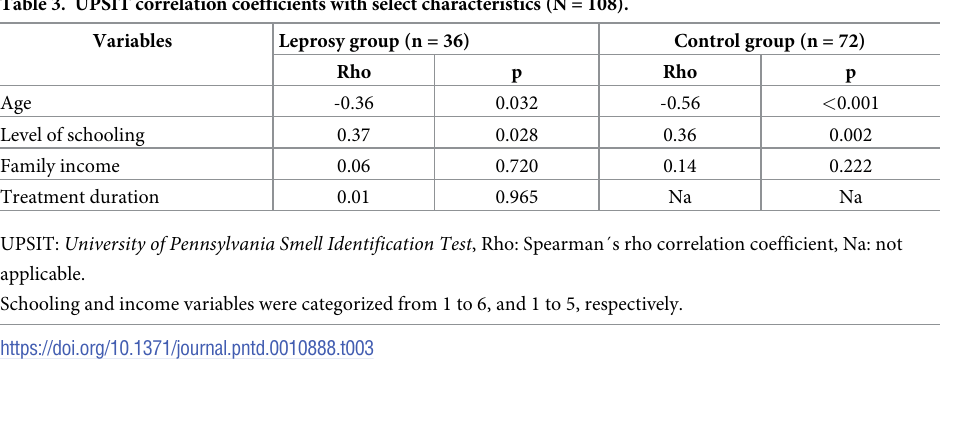
Table 3. UPSIT correlation coefficients with select characteristics (N = 108).